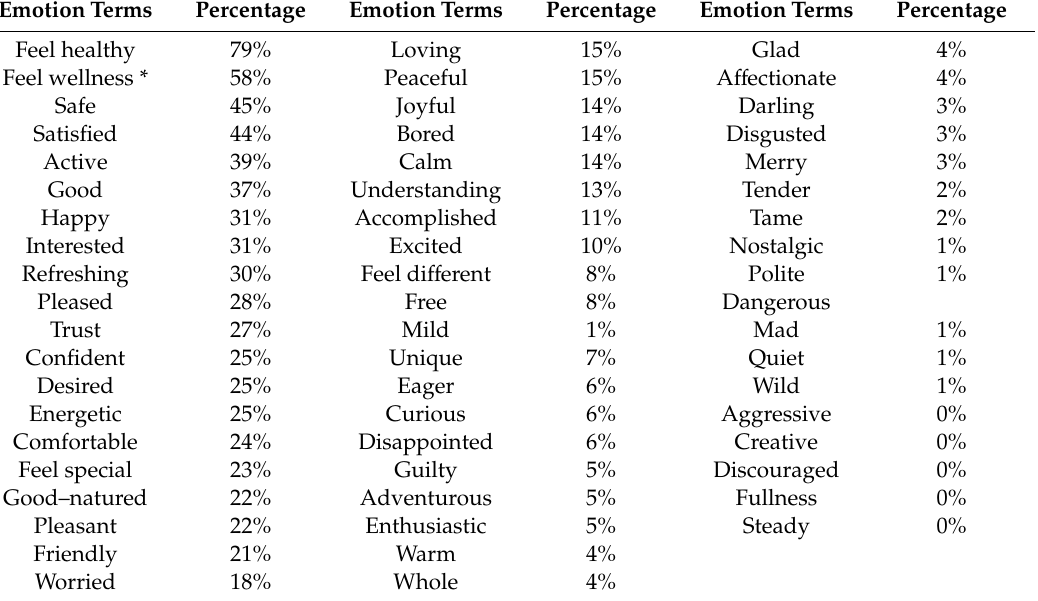
Table 2. Percentage of emotion terms (58) elicited by ready-to-eat (RTE) salads and mentioned by consumers (N =